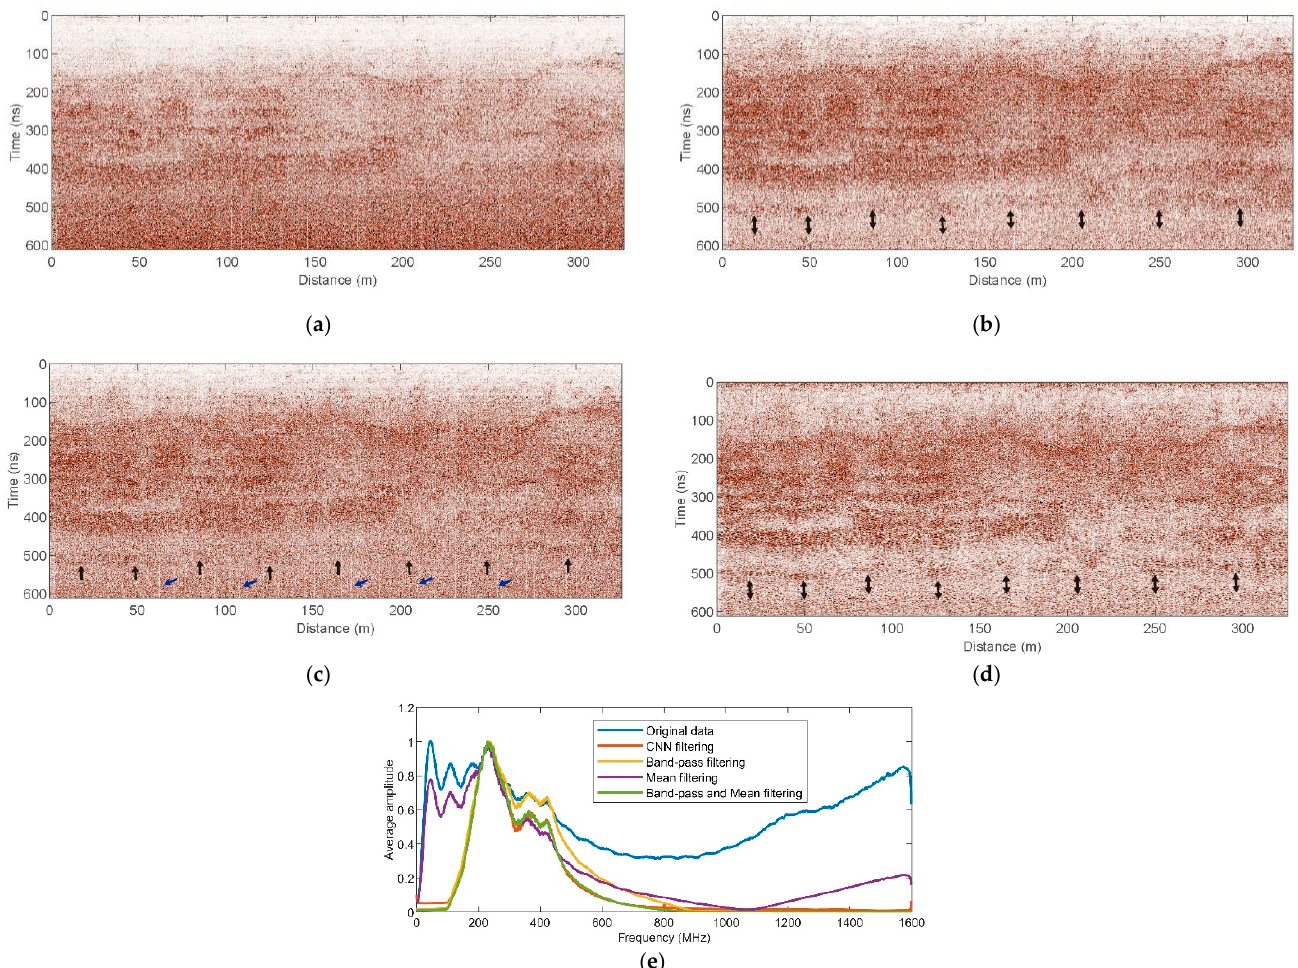
Figure 12. Result and comparative analysis of the applied filtering methods. ( a ) The radargram after the mean filtering; ( b ) the radargram after the CNN filtering; ( c ) the radargram after the band-pass filtering and the mean filtering; ( d ) the radargram after the band-pass filtering and Kirchhoff migration, the velocity used in migration is 0.14 m/ns [9]; ( e ) the comparison of the average frequency amplitude spectra. The black arrows in ( b – d ) indicate the extracted weak reflected signals. The blue arrows in ( c ) point out the strips of interference.